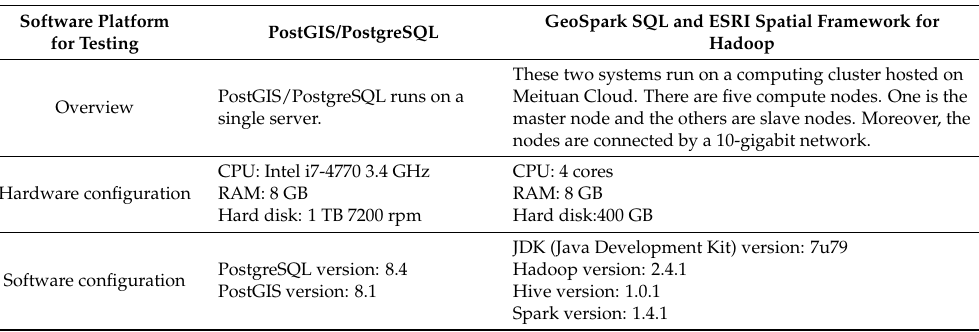
Table 2. Descriptions of testing platforms.